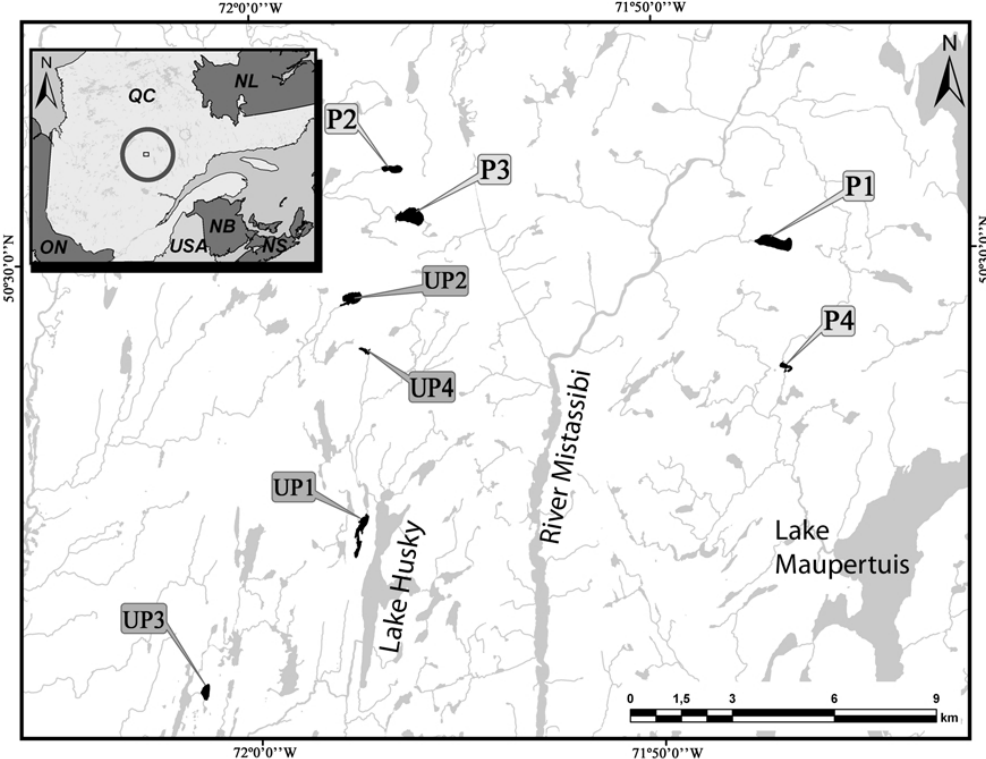
Figure 1. Location of the eight study lakes sampled in 2008, 2009 and 2010. UP, unperturbed lakes; P, perturbed lakes (harvested in